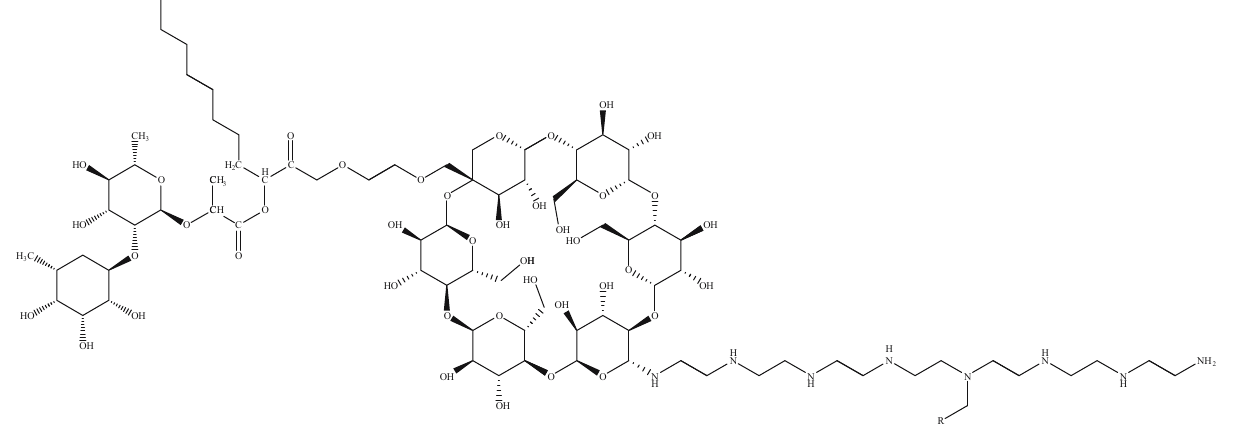
Figure 1: Schematic diagram of the molecular structure of a new environmentally friendly waste water - based drilling fl uid adsorbent RH - β - CD.